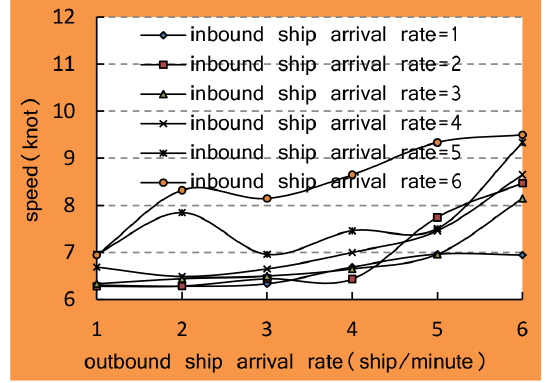
Figure 18. Average speed of waterway system and outbound ship arrival rate as a function at variable inbound ship arrival rate (when allow changing)